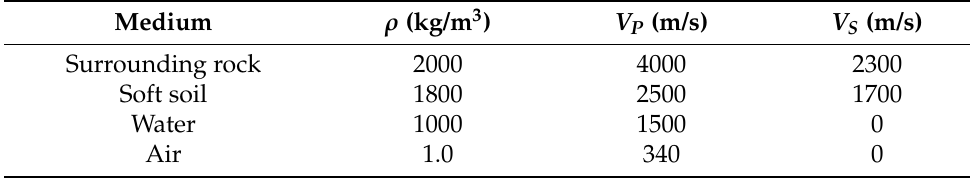
Table 1. Physical parameters of the different mediums in the karst cave